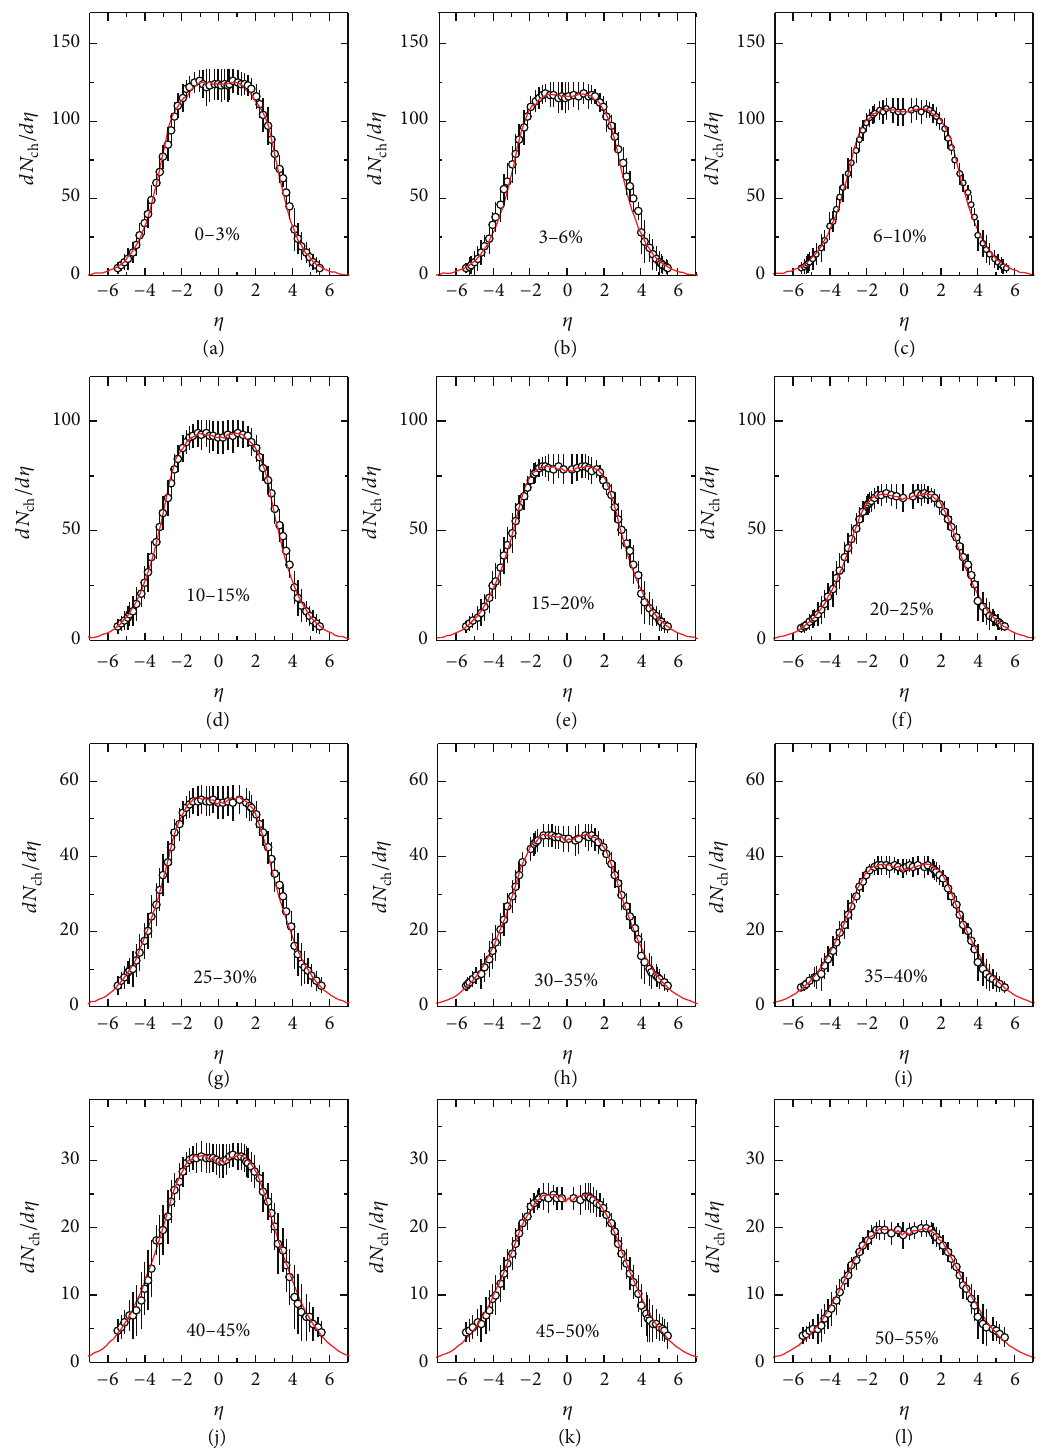
Figure 6: The same as Figure 1 but showing the results of Cu-Cu collisions at √ 𝑠 NN = 62.4